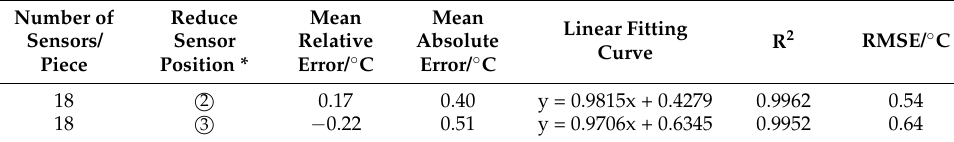
Table 5. Linear correlation analysis results after reducing 6